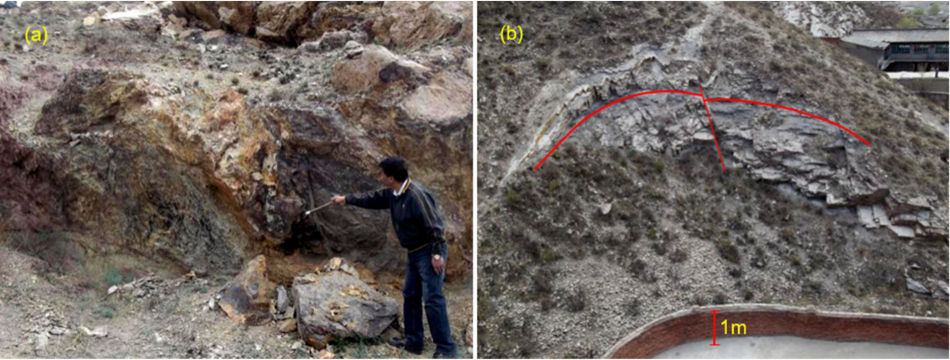
Figure 9. The outcrop of the Kouquan fault-fold zone ( a ) the fold transition in Benxi Formation C 2 b; ( b ) the small fold fault in Shanxi Formation P 1